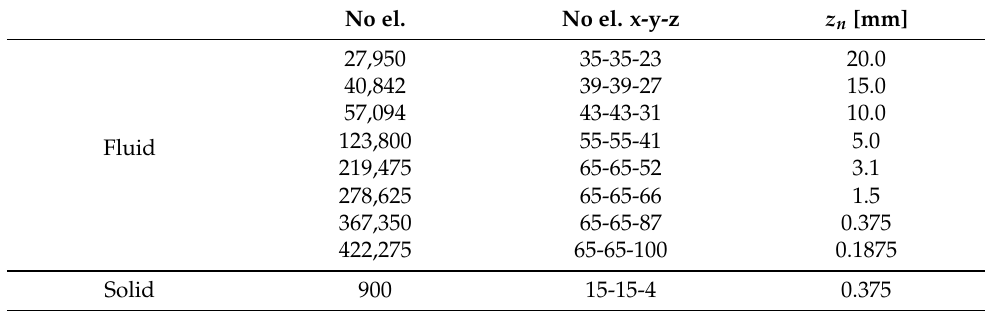
Table 7. The regions’ meshes are always conformal at the top and bottom surface to avoid interpolation errors. Table 7. Fluid and solid regions’ meshes characteristics, mentioning the total number of elements, the number of elements in x, y, z coordinates and boundary cells interface perpendicular dimension z n identical at the specimen top and bottom. Growth ratio within the fluid region is used. Its value is around 1.1, never exceeding it. No